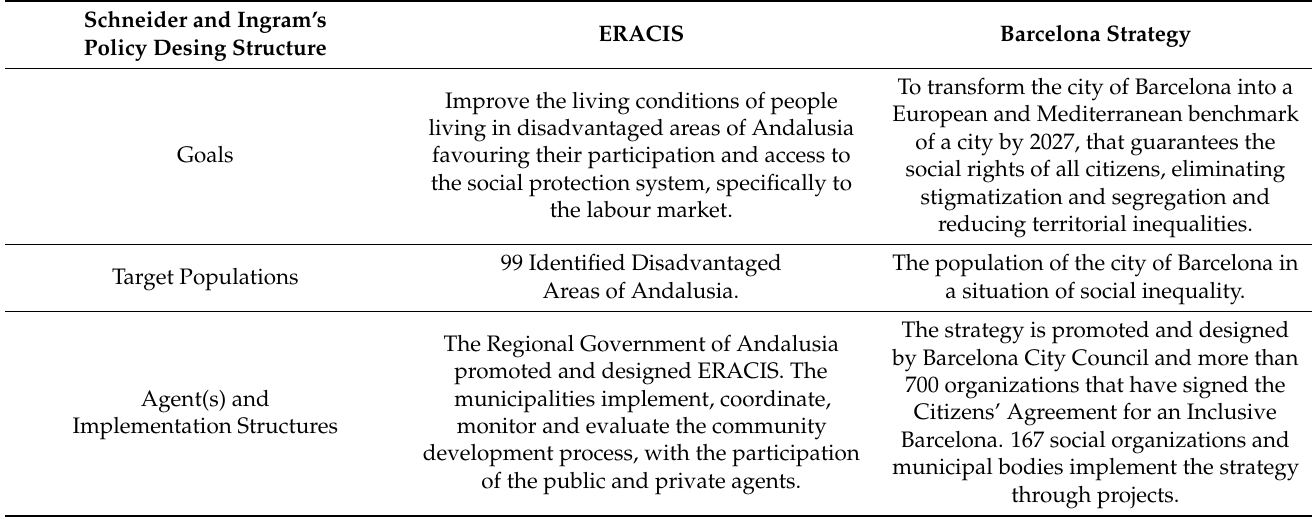
Table 1. Comparing policy design elements in ERACIS and Barcelona